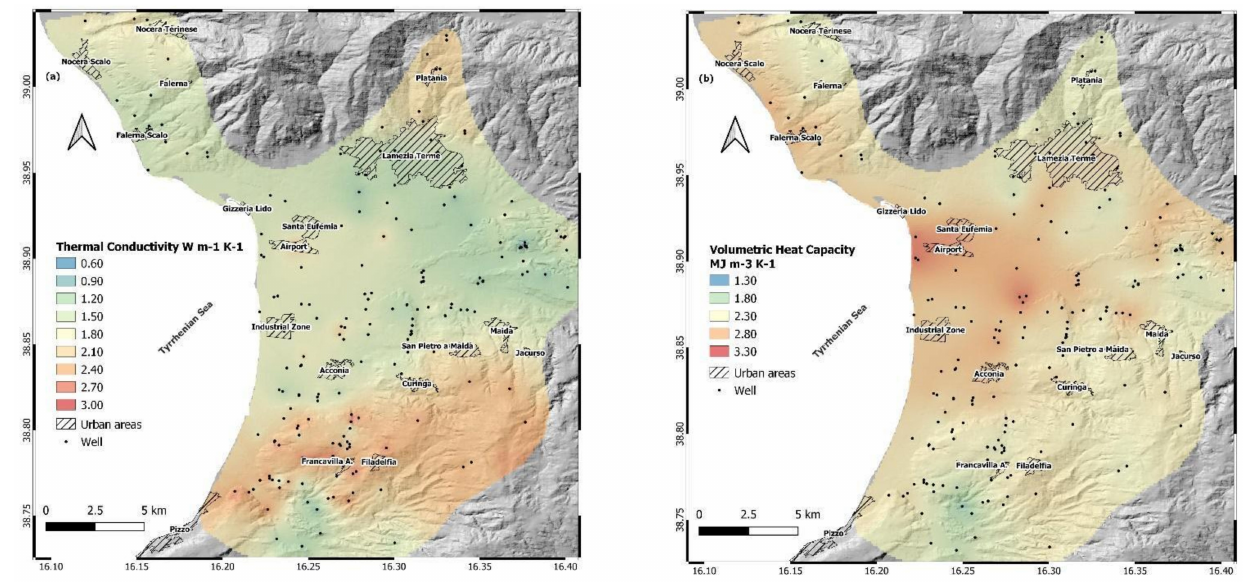
Figure 3. Maps of the estimated ( a ) thermal conductivity ( λ ) and ( b ) volumetric heat capacity (SVC or ρ c ) of the ground averaged over 100 m of depth from the surface in the